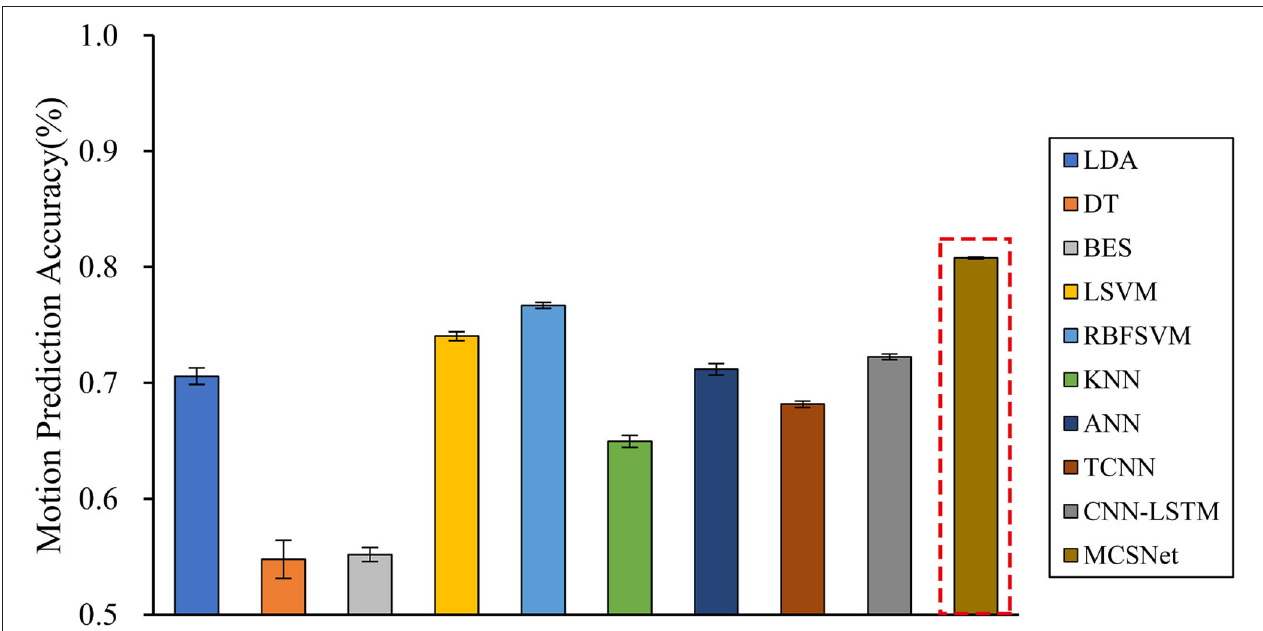
FIGURE 5 | Cross-subject movement prediction performance, averaged over all folds. Error bars denote two standard errors of the mean.